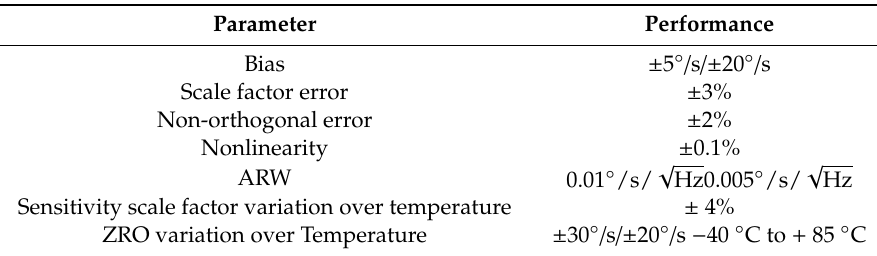
Table 2. MPU-9255 / 9150 Characteristic.